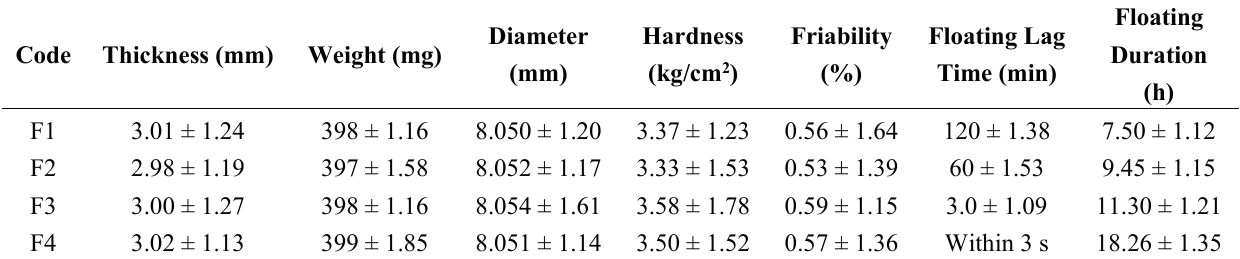
Table 3. Physicochemical properties of the MSC CMN gastro-retentive floating